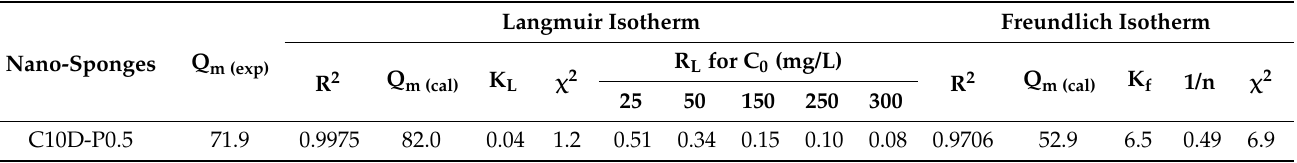
Table 3. Langmuir and Freundlich isotherm parameters (conditions: 2 g/L of adsorbent dosage, 180 min of contact time, pH of 6.5, and temperature at 303